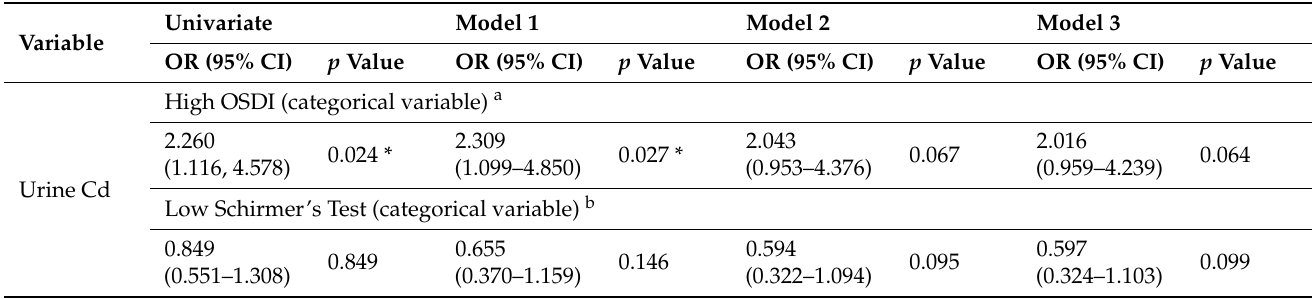
Table 5. Association between urinary Cd and high-OSDI and low Schirmer’s test scores.